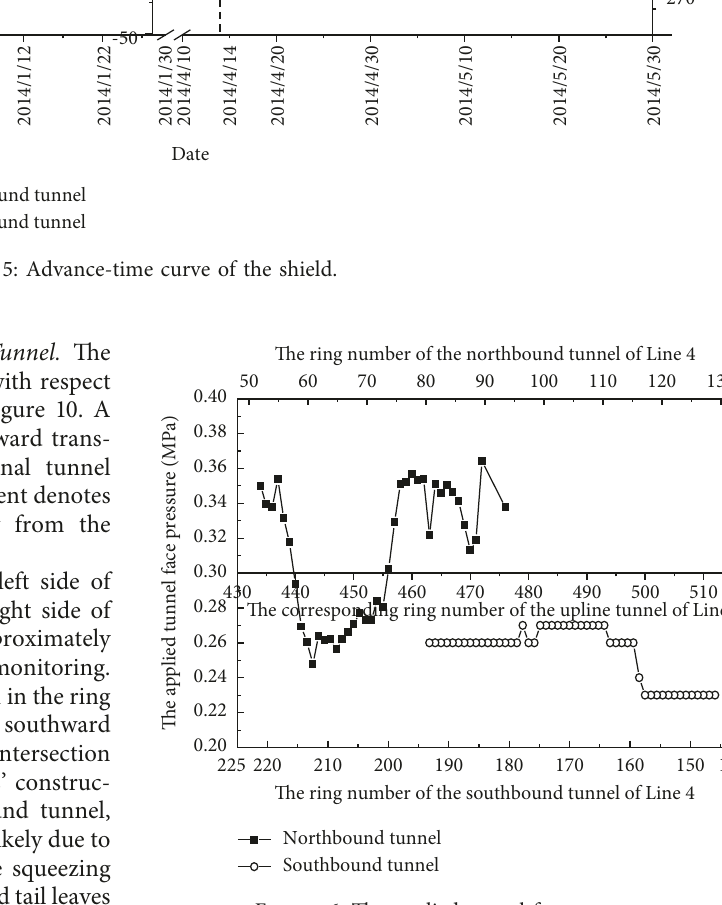
Figure 6: The applied tunnel face